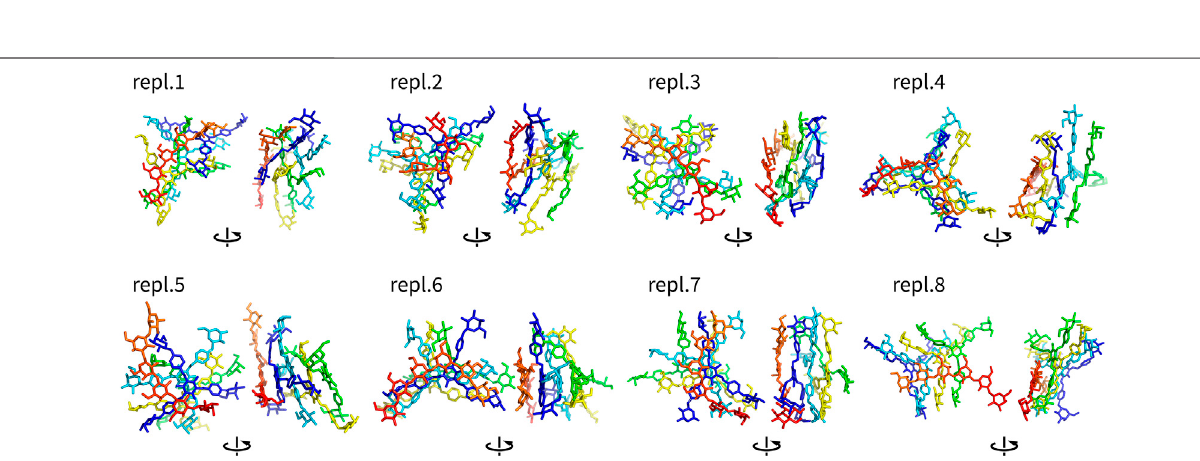
Frontiers in Molecular Biosciences |